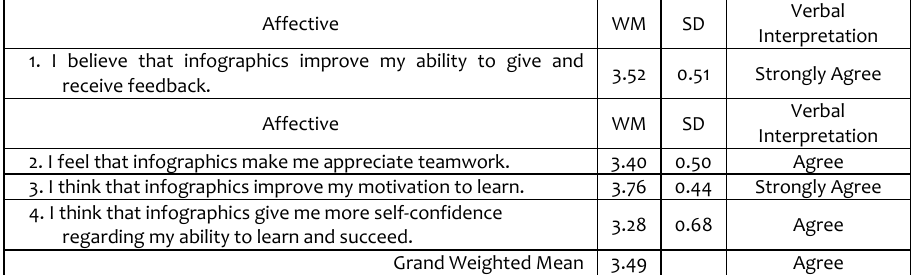
Table 5: Respondents’Perception of the Impacts of Infographics in Terms of Affective Development Affective WM